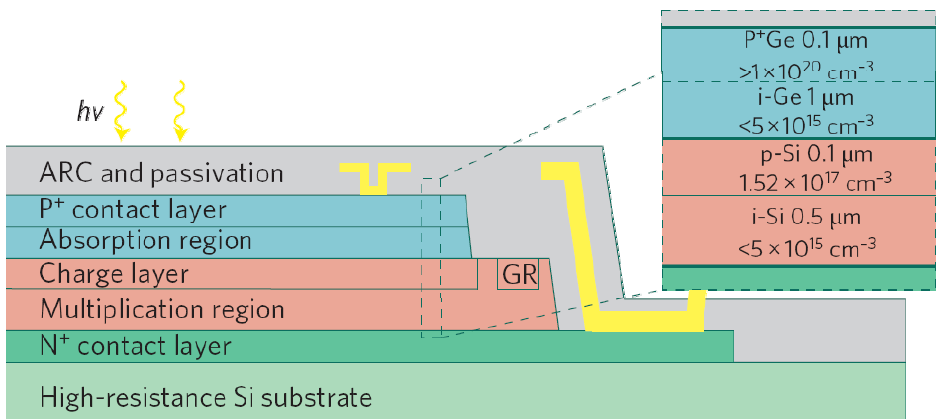
Figure 8. Schematic of Ge/Si APD with a typical SACM configuration. From